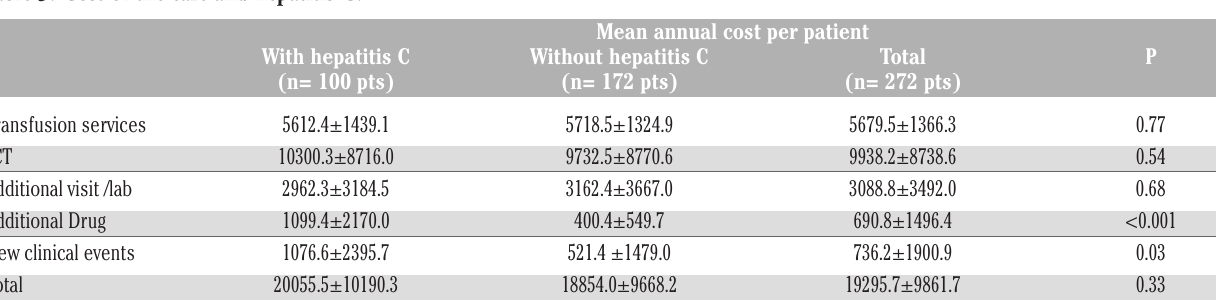
Table 3. Cost of the care and hepatitis